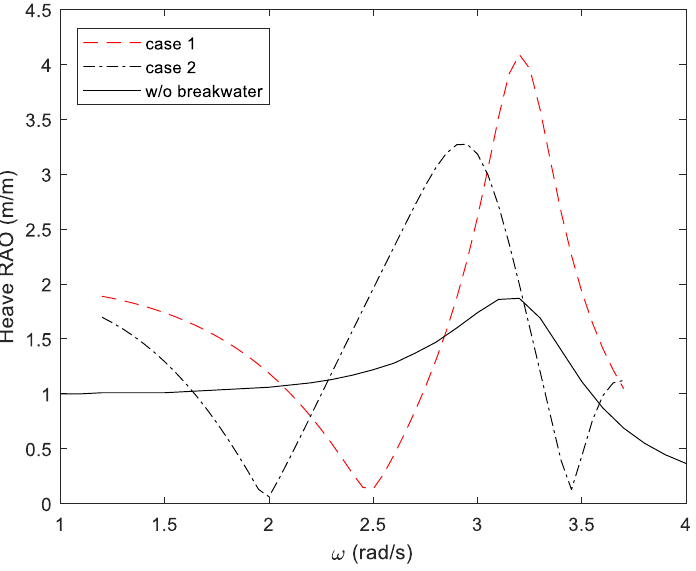
Figure 16. Heave RAOs under various distance conditions between the wall and floater.